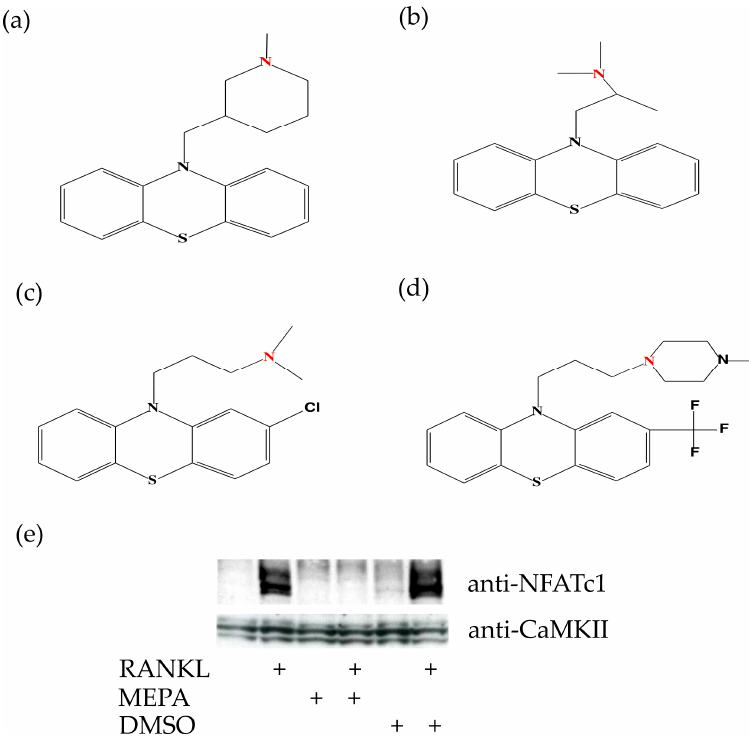
Figure 4. Mepazine inhibits RANKL-induced NF-AT1 expression. ( a ) Molecular structure of Mepazine ( b ) Promethazine ( c ) Chlorpromazine ( d ) Trifluoperazine, with the critical N group proposed